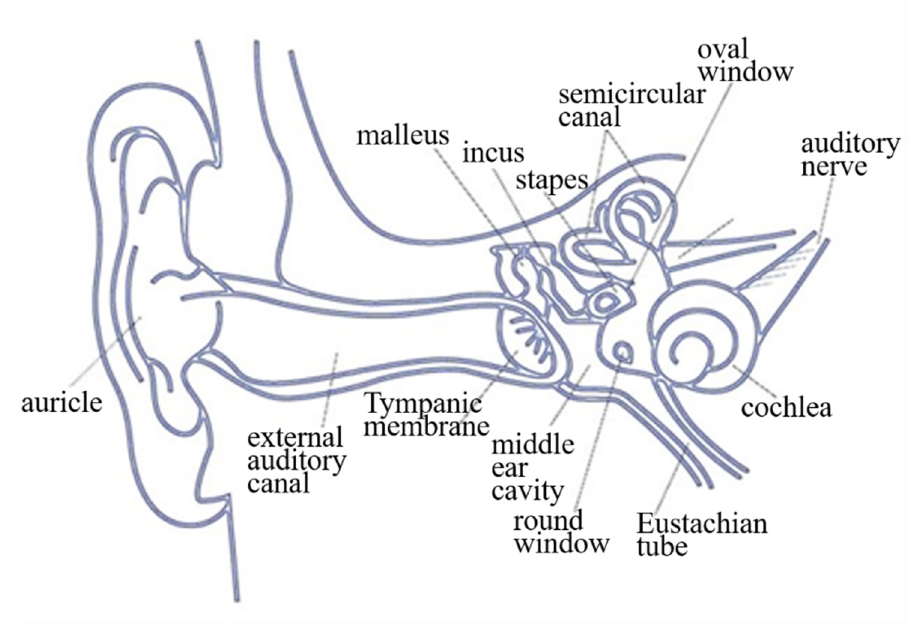
Figure 1. Structure of the human ear.